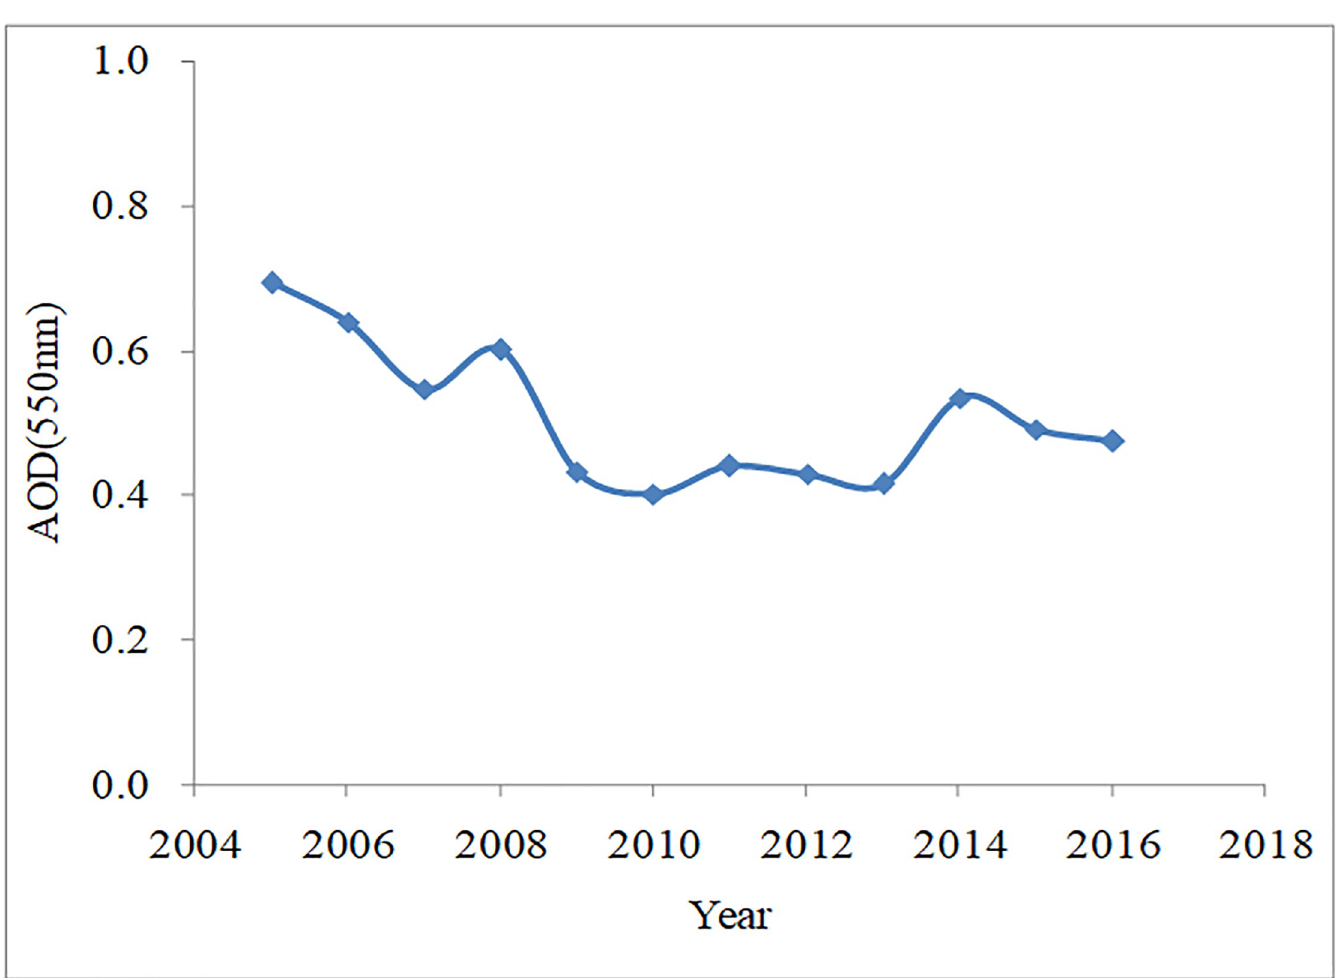
Fig 2. Interannual variation in 550 nm AOD from 2005 to 2016 in